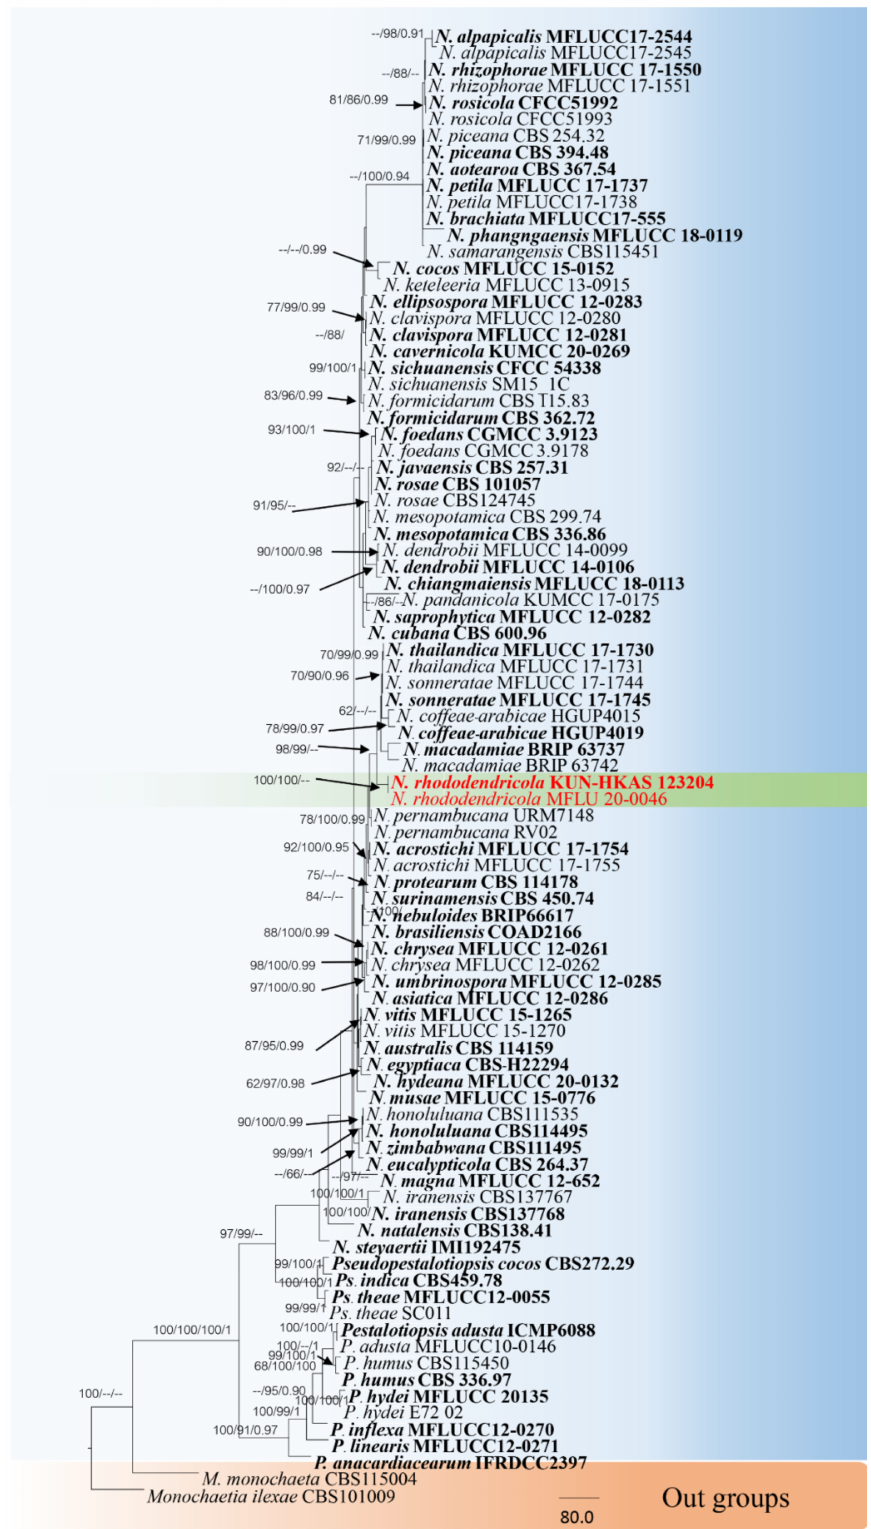
Figure 2. RAxML tree based on a combined dataset of ITS, TUB2 and TEF1 gene regions. Bootstrap support values for ML and MP equal to or greater than 60% and Bayesian posterior probabilities (PP) equal to or greater than 0.90 are defined as ML/MP/PP above or below the nodes. Our new taxon is indicated in red. The tree was rooted with Monochaetia monochaeta strains (CBS115004) and Monochaetia ilexae strains